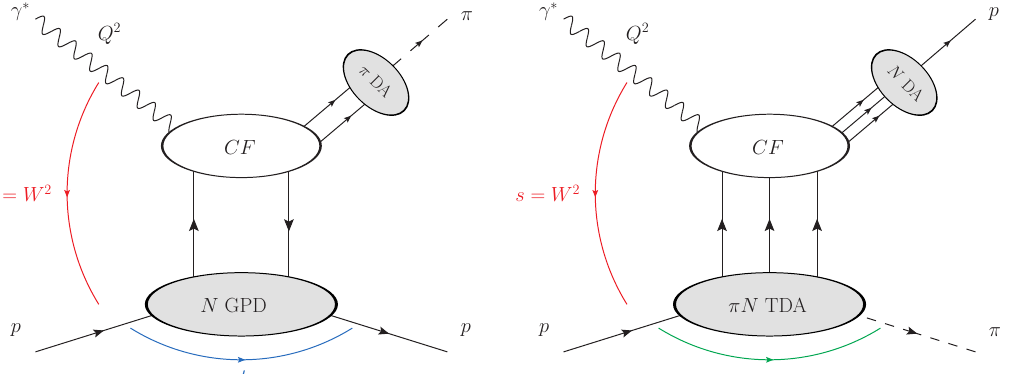
Figure 2: Left: shows the π 0 electroproduction interaction ( γ ∗ p → p π 0 ) diagram under the (forward-angle) GPD collinear factorization regime (large Q 2 , large s , fixed x , fixed t ∼ t ). N GPD is the quark nucleon GPD (note that there are also gluon min B GPD that is not shown). π DA stands for the vector meson distribution